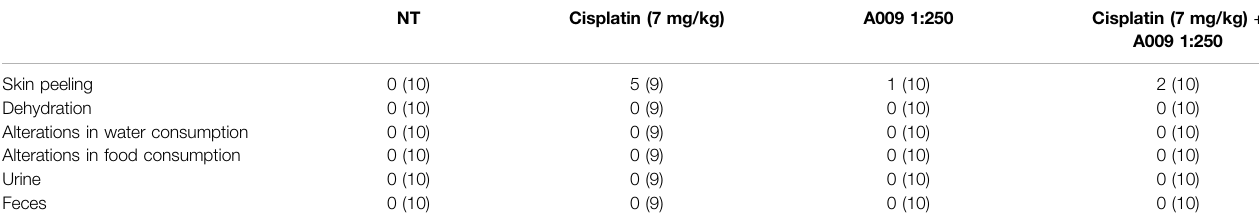
The healthy stateon mice receiving single agent (A009, dilution1:250) alone, or Cisplatin (7 mg/kg)alone, or the combinationsof Cisplatin with theA009 extract was daily monitored. As readoutofclinicalparameters,thepresenceofskinpeeling,dehydration,alterationsofwaterandfoodconsumption,alterationinsolid(feces)andliquid(urine)dejectionsareshowed.Data are presented as (number of events)/total animal per experimental